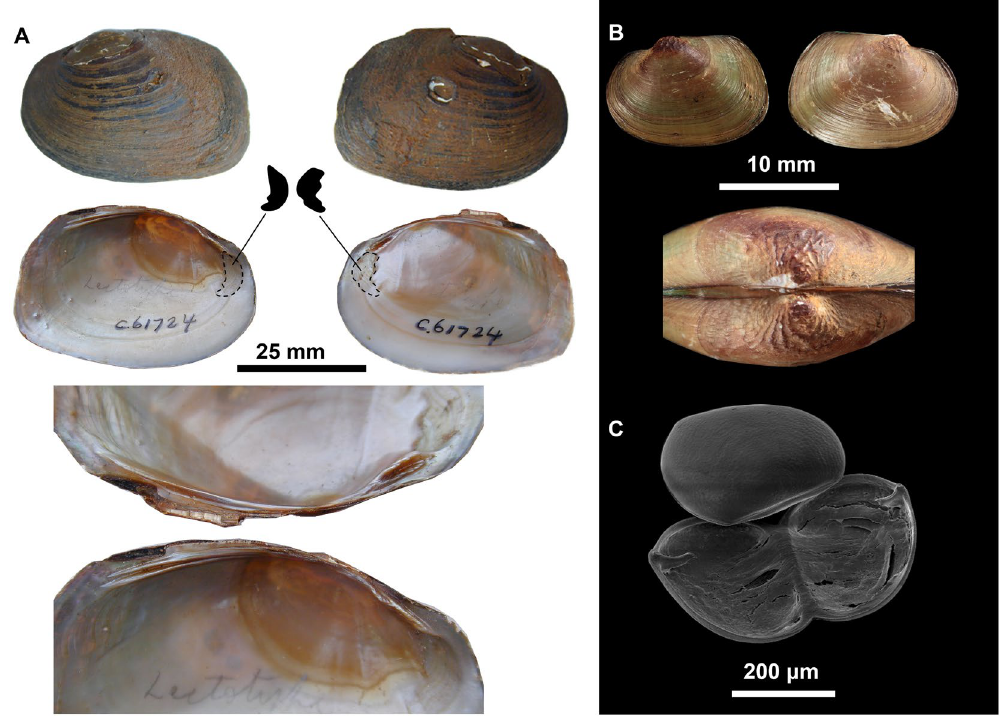
Figure 3. ( A ) Westralunio ambiguus carteri Iredale, 1934, Lectotype: Victoria Reservoir, Darling Range, 12 mi E of Perth, AMS C.061724. Detail of fusion in anterior muscle scars from either valve represented by dashed lines and black polygons. Bottom image showing detail of hinge teeth. Photos provided with permission by Dr Mandy Reid, AMS. ( B ) Valves and detail of sculptured umbo of a juvenile W. carteri from Yule Brook, Western Australia, UMZC 2013.2.9. Photo by Dr Michael W. Klunzinger. ( C ) Glochidia of W. carteri from Canning River, Western Australia. Photo by Dr Michael W.